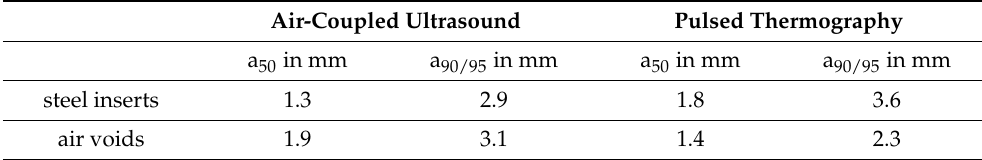
Table 2. Parameters obtained from the POD curves for air-coupled ultrasound and thermography.